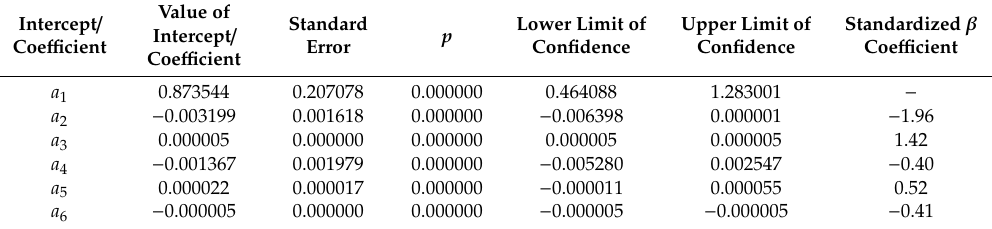
Table 13. Statistical evaluation of O content model of torrefied pruned